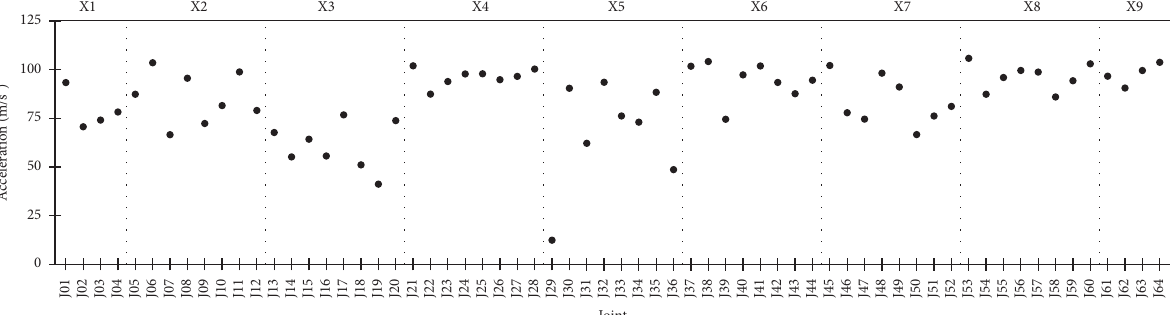
Figure 5: Average absolute peak acceleration response.